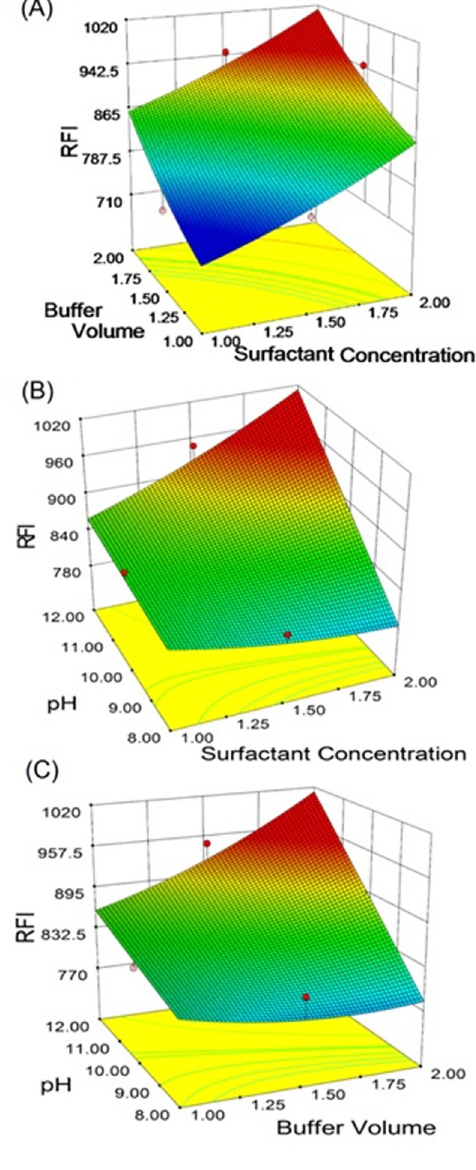
Fig 9. Response surface graphs showing the influence of kolliphor RH 40 surfactant concentration, volume of buffer and buffer pH on RFI values of the interaction mixture with LAP. Panel (A): effect of surfactant concentration and buffer volume on RFI of LAP while keeping pH constant. Panel (B): effect of surfactant concentration and buffer pH on RFI of LAP, while keeping buffer volume constant. Panel (C): effect of buffer volume and pH on RFI of LAP, while keeping surfactant concentration